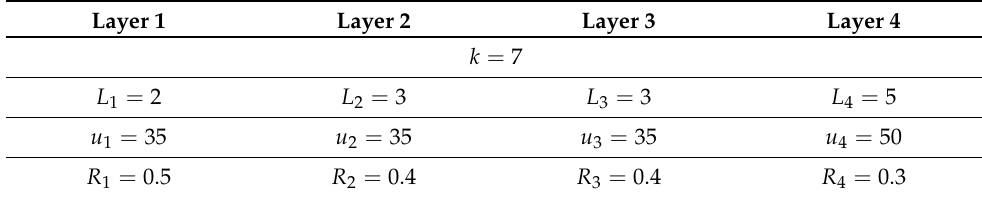
Table 4. Parameters for 1-D